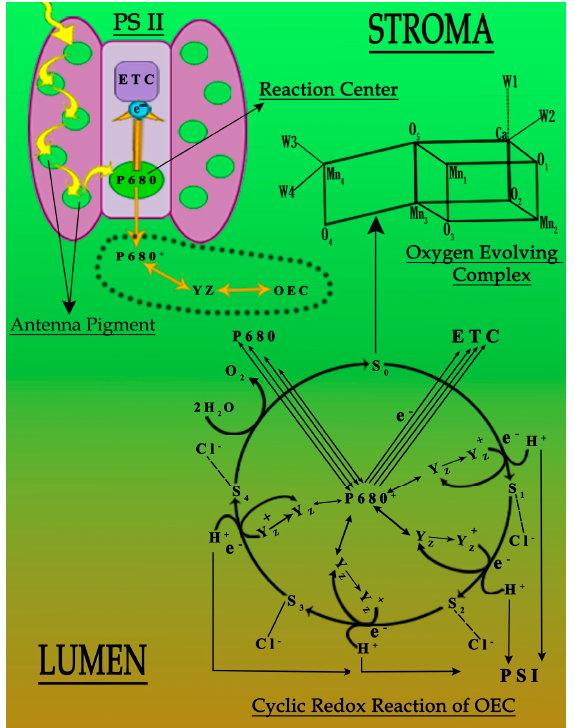
Figure 4. Probable deactivation of photosystem II under the influence of Cu and Pb metals.